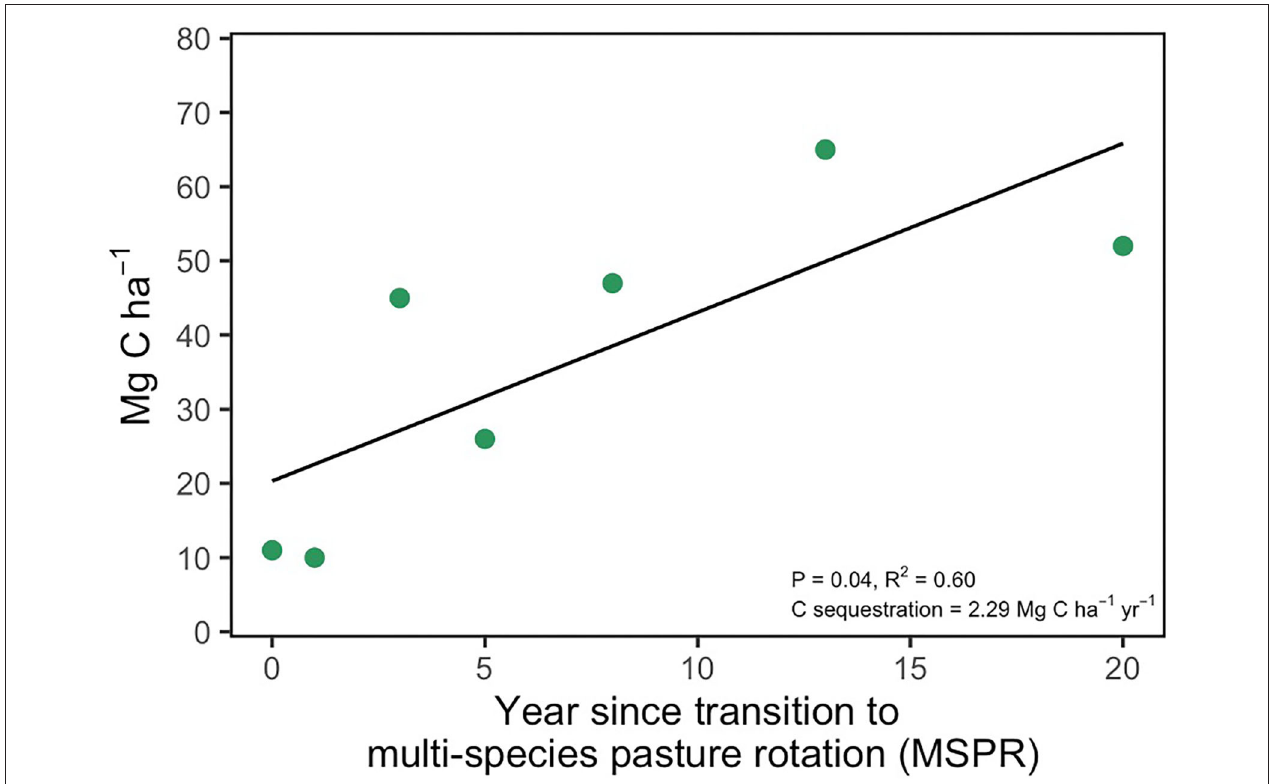
FIGURE 2 | Soil carbon stock at equivalent soil mass of 9,900 Mg/ha. Points represent least-squared means adjusted for soil clay content generated from 4 in-field replicate soil